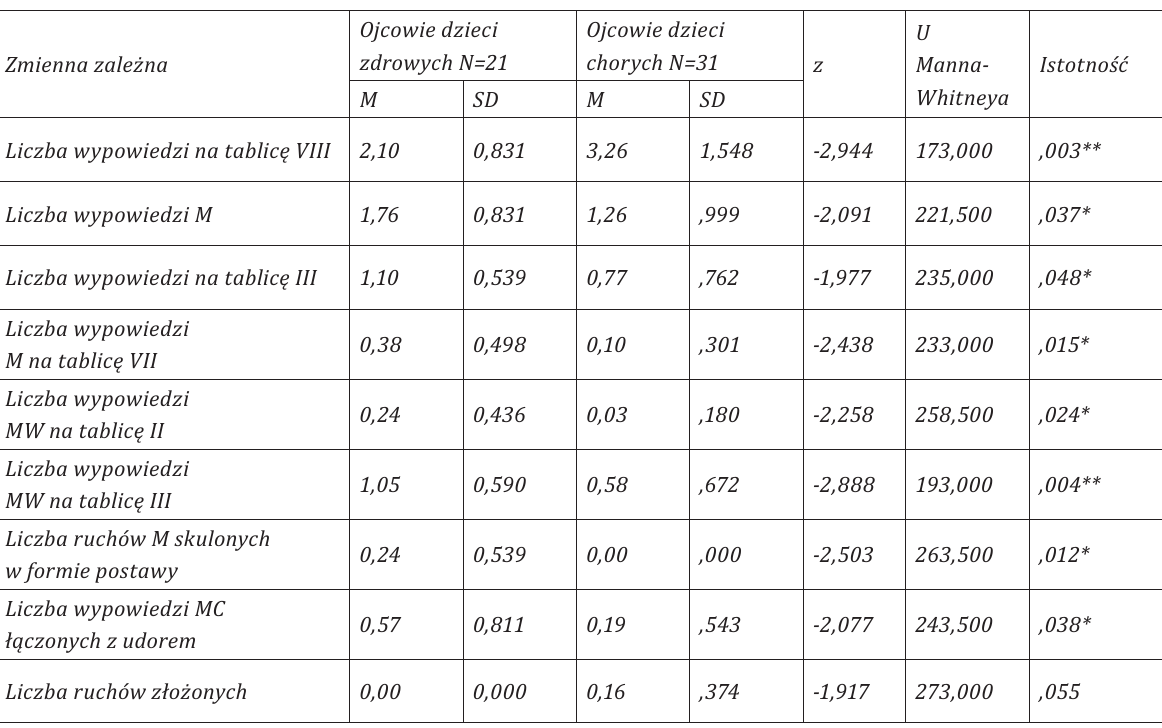
Jak mówią dane zawarte w Tabeli 3., matki chorych dzieci dawały istotnie mniej wypowiedzi na tablicę VI, a także mniej wypowiedzi na tablicę VII. chorych